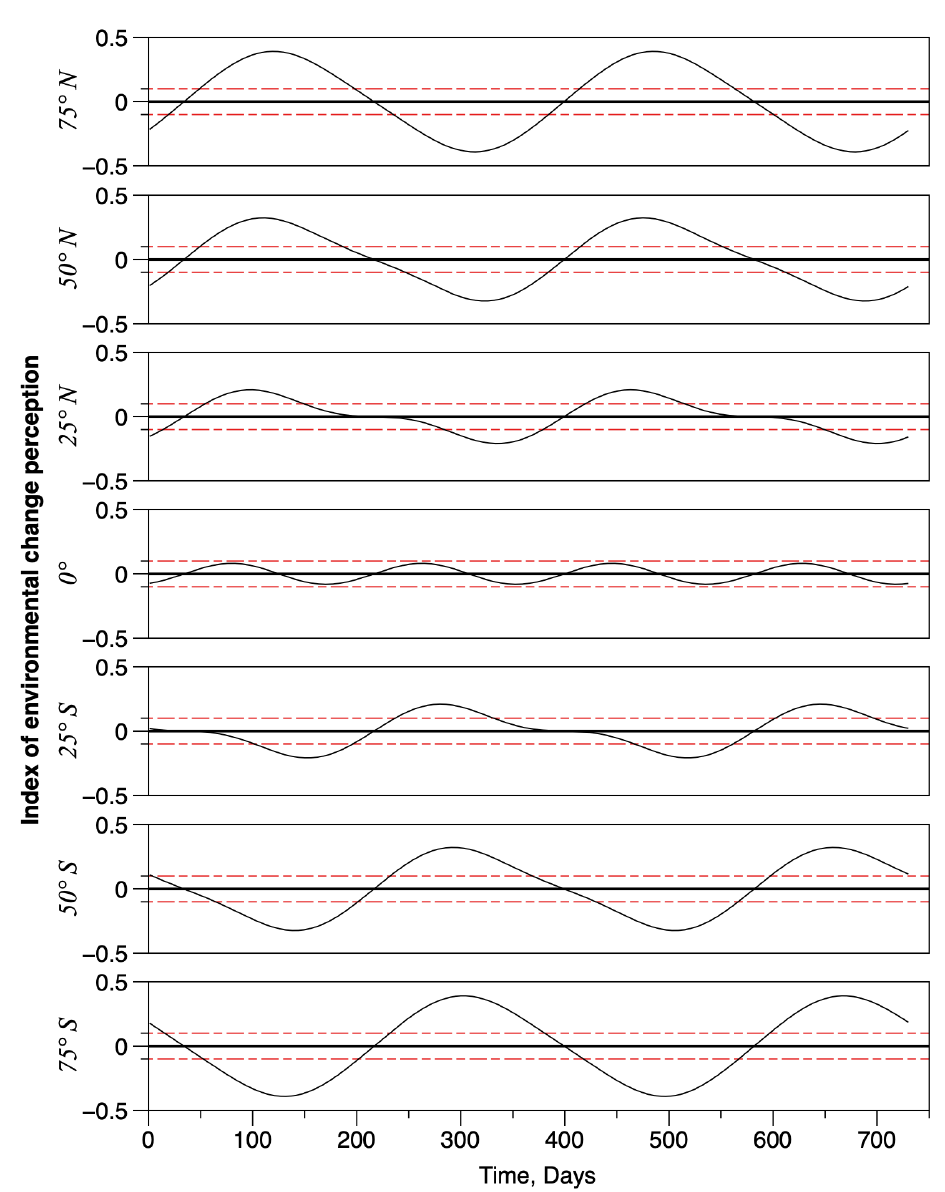
Figure 3. Examples of the spatio-temporal fluctuations of environmental changes as perceived by individuals in the model. The black curves represent the variations of the index of perceived changes. The red dashed lines are the 0.1 and − 0.1 thresholds, above and below which environmental change perceptions are significant (positively and negatively, respectively). The black solid line indicates the zero baseline. Seven latitudes are represented, showing the doubling of the oscillation when converging to the equator. In addition, at the equator, there is no significant perception of environmental